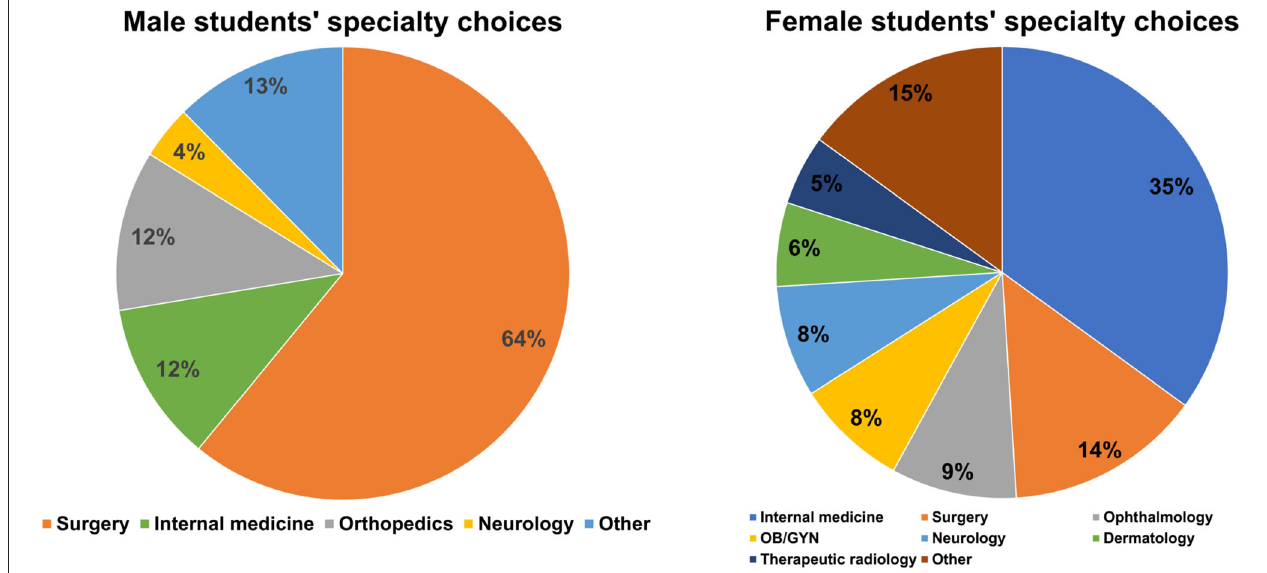
FIGURE 1 | The male and female medical students’ specialty